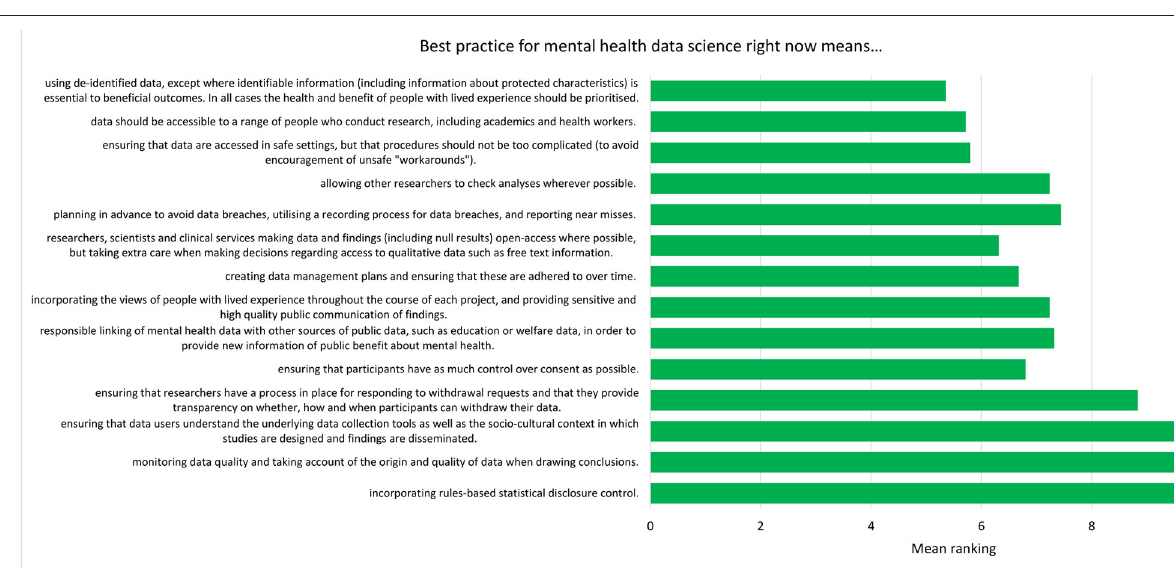
Frontiers in Psychiatry |